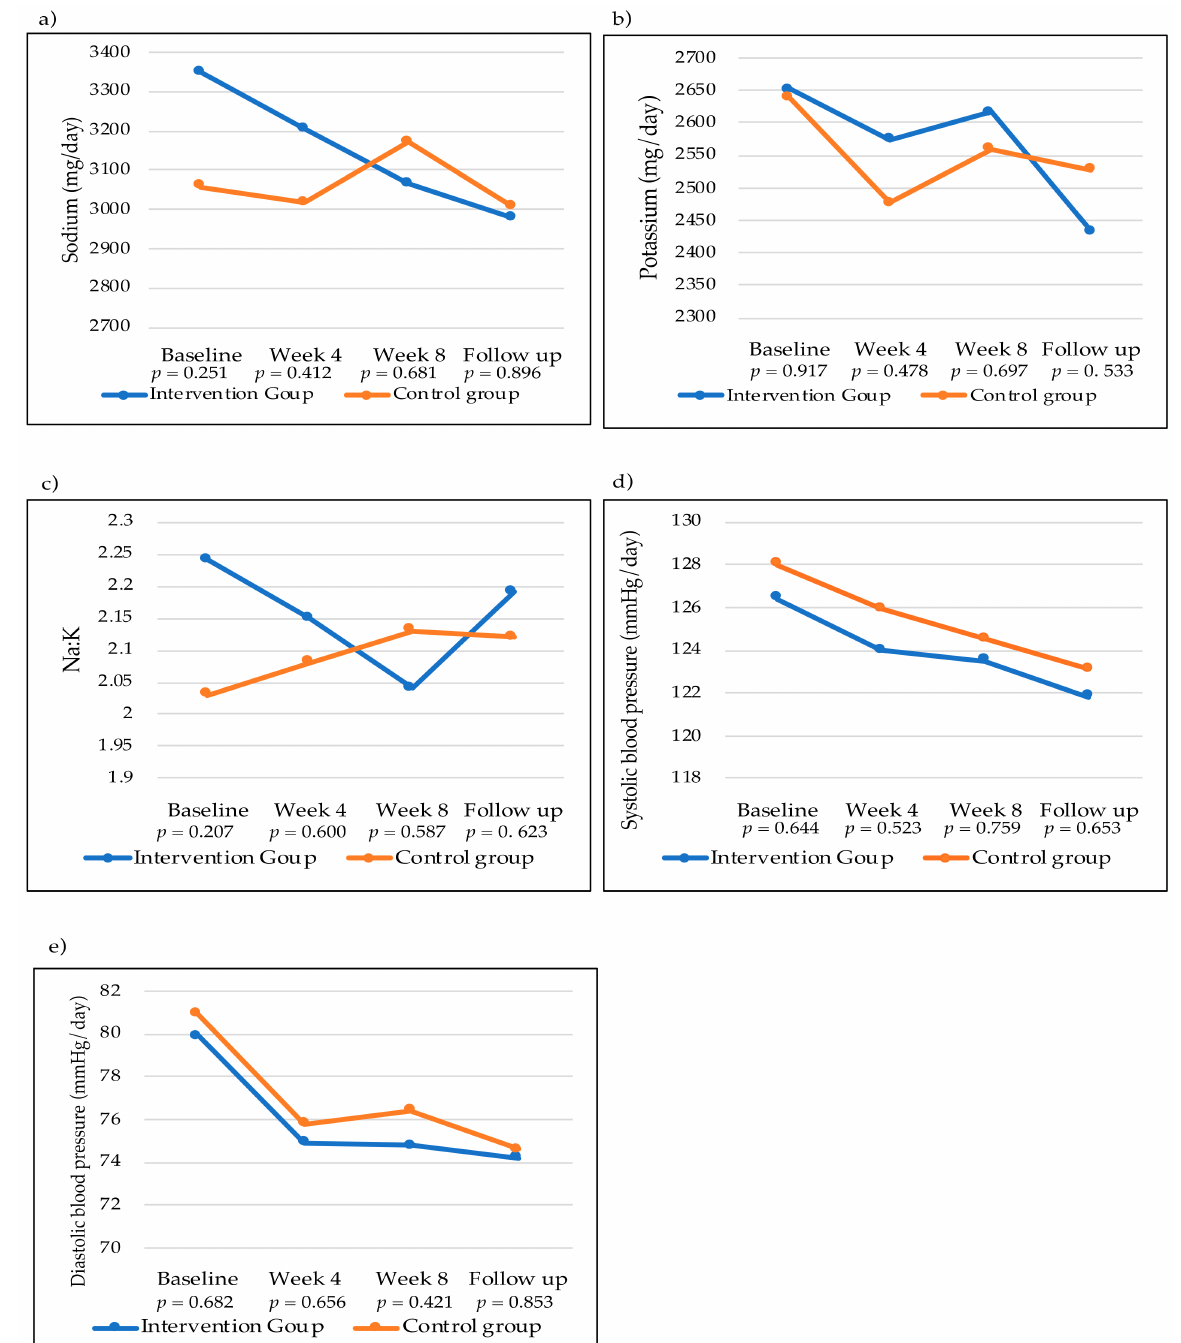
Figure 3. Two-dimensional (2D) line graphs with markers of the means of the four assessments of sodium and potassium excretion, Na:K ratio, and blood pressure in the intervention and control groups performed throughout the study. ( a ) Urinary sodium excretion (mg/day) of the intervention and control groups; ( b ) Urinary potassium excretion (mg/day) of the intervention and control groups; ( c ) Na:K ratio of the intervention and control groups; ( d ) Systolic blood pressure (mmHg/day) of the intervention and control groups; ( e ) Diastolic blood pressure (mmHg/day) of the intervention and control groups. p -Adjusted mean difference between intervention group and control group (sodium and potassium excretion and Na:K ratio were adjusted for energy intake and blood pressure was adjusted for skin